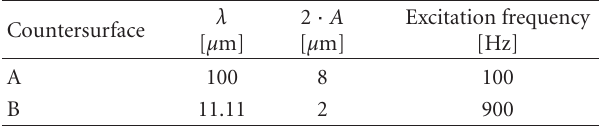
Table 1: Characteristic sizes of the surface roughness models and the corresponding excitation frequencies.